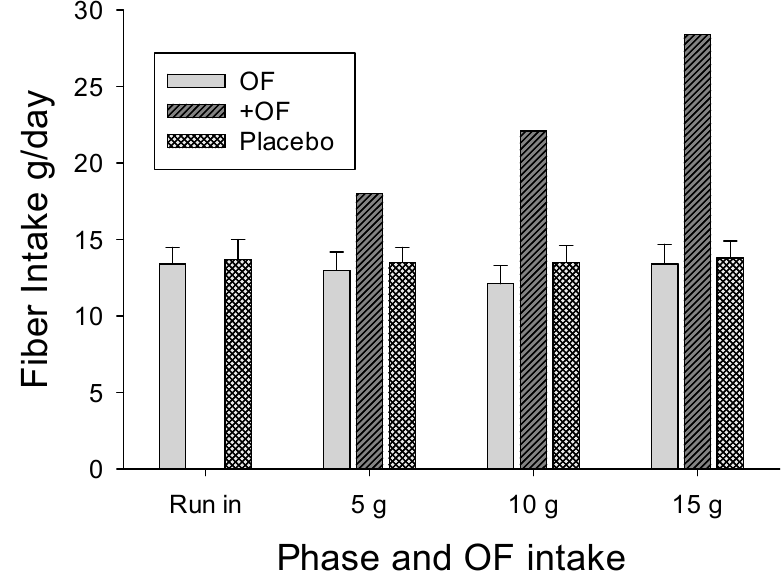
Figure 2. Bars showing mean habitual dietary fiber intakes of groups (with and without supplemental oligofructose (OF)) at different treatment phases. OF group: Habitual dietary fiber intake of OF group without taking into account supplemental OF. +OF group: Habitual fiber of OF group with the supplemental OF. Maltodextrin (MD) group: Placebo group.